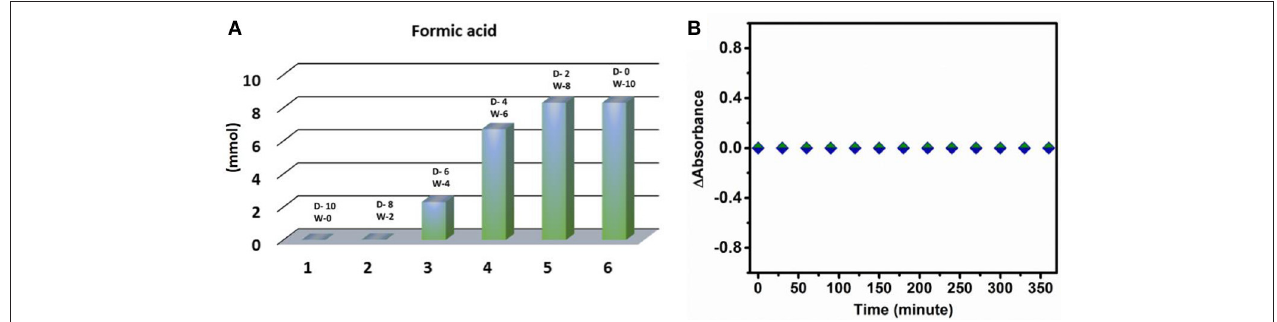
FIGURE 4 | (A) Variation of DMF and water content in reaction mixture (D-DMF, W-water, all values given in ml unit). (B) Plot of change of absorbance of {Mo 368 } with time vs. reaction time.